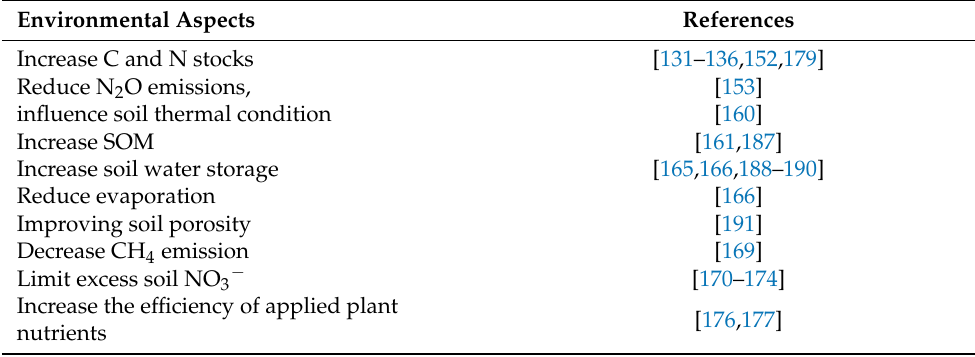
Table 3. Environmental aspects influenced by the use of cover